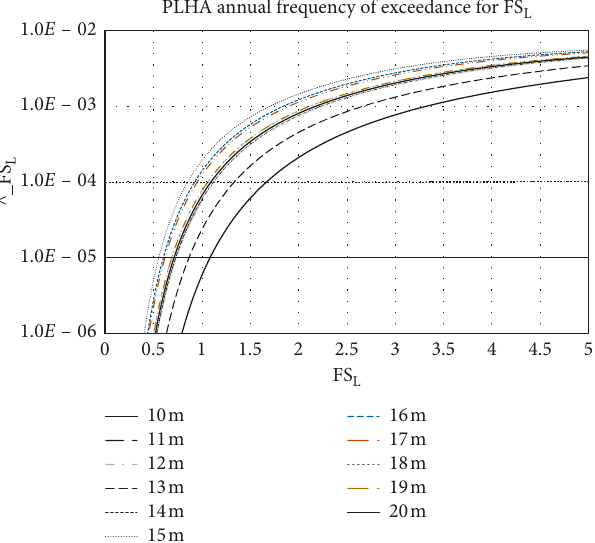
L (hazard curve) for